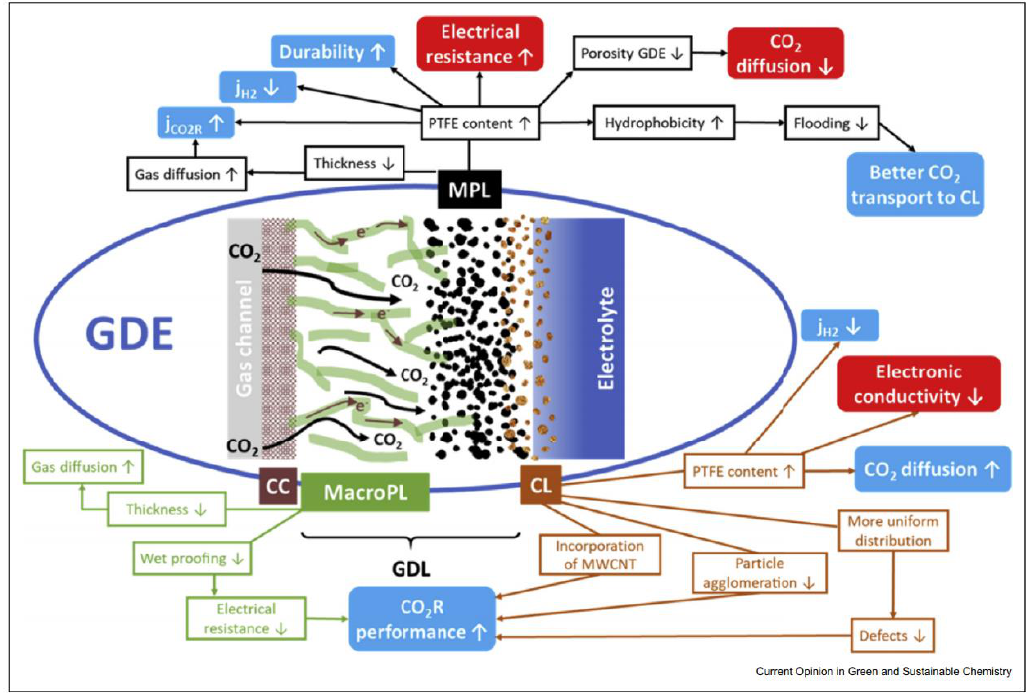
Figure 10. Simplified schematic of a gas diffusion electrode (GDE) showing interlinked contributions of gas diffusion layer (GDL) and catalyst layer (CL) design parameters. Black, brown, and green refer to microporous layer (MPL), CL, and macroporous layer (MacroPL, i.e., microporous substrate, MPS), respectively. Positive effects are presented in blue, negative effects are presented in red. The increase ( ↑ ) or decrease ( ↓ ) of parameters is also shown. PTFE, polytetrafluoroethylene; CC current collector; j, current density; MWCNT, multi-walled carbon nanotubes. Reproduced with permission from reference [204] .